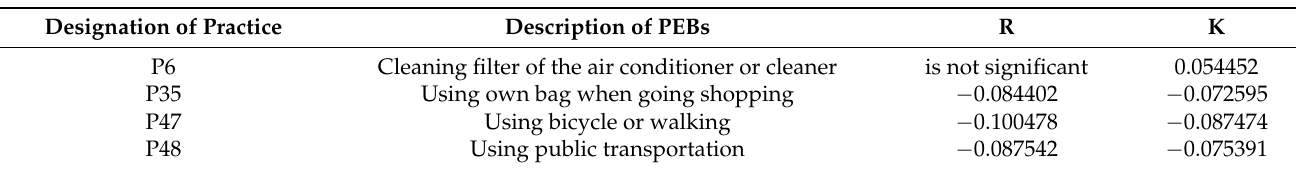
Table 8. Correlations (at the p = 0.05 level) between the respondent’s income level and the frequency of using proenviron- mental practices.